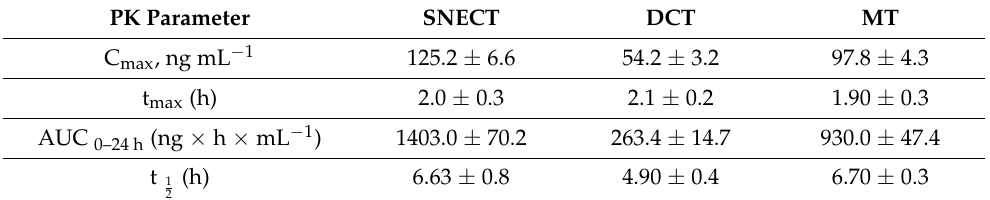
Table 9. Pharmacokinetic parameters of TDL in rats after oral administration (1 mg/kg, n =